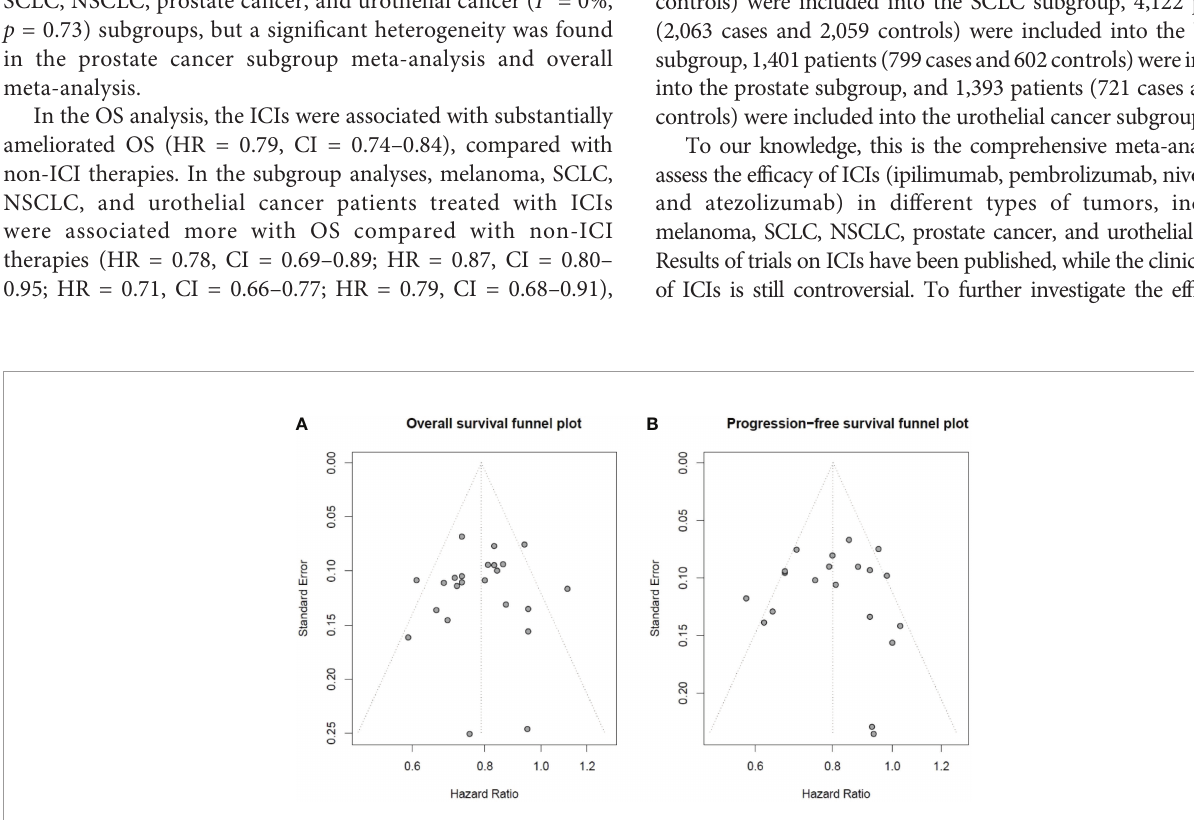
FIGURE 2 | Begg ’ s funnel plot of overall survival and progression-free survival studies: (A) Begg ’ s funnel plot of overall survival studies to evaluate publication bias. (B) Begg ’ s funnel plot of progression-free survival studies to evaluate publication